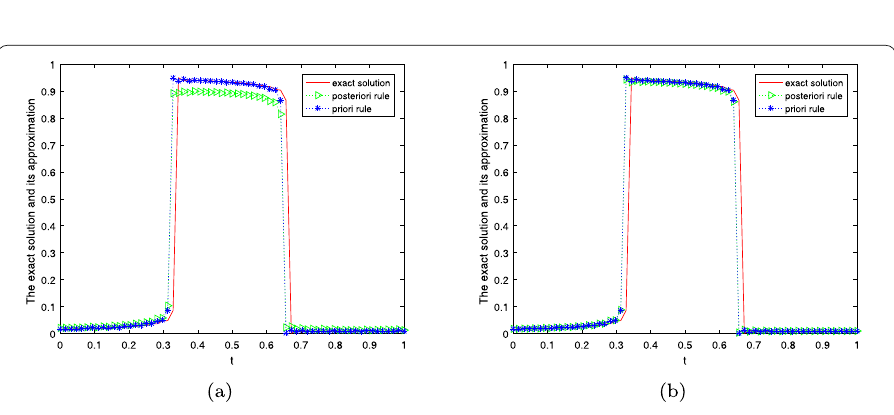
Figure 6 The comparison of the exact solution and its approximation solution for α = 0.3 at x = 0.1 with Example 5.3, ( a ) (cid:13) = 0.001, ( b ) (cid:13) =